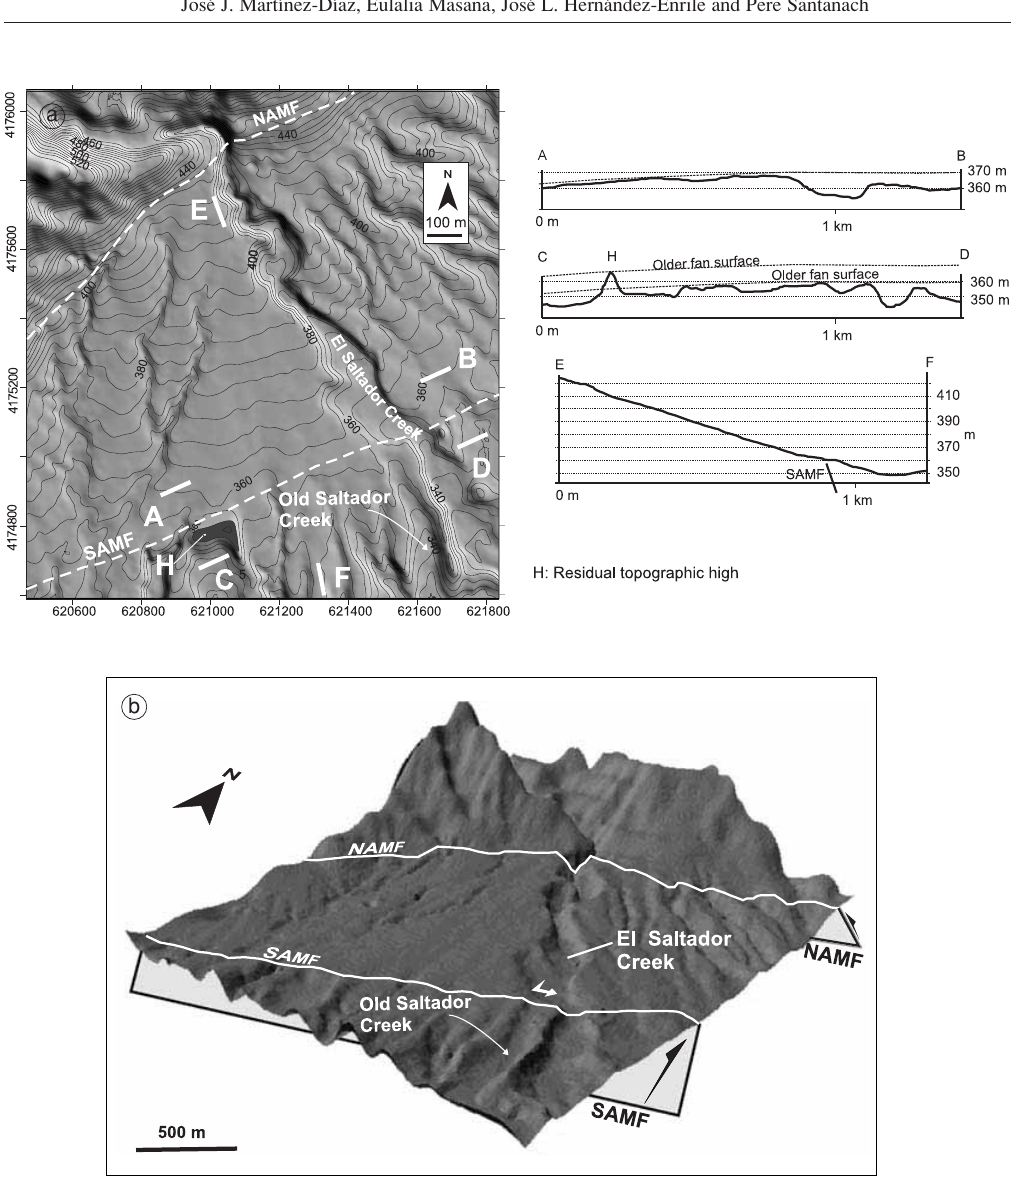
Fig. 4a,b. a) Shaded relief map processed from cartographic data at the 1:5000 scale showing the El Saltador alluvial fan together with the fault traces of the Northern and Southern Alhama de Murcia Fault (NAMF and SAMF). To the right the longitudinal (E-F) and transversal (A-B and C-D) topographic profiles of the fan show different degree of dissection of the fan surface in the foot-wall and hanging-wall of the SAMF. H represents a relict of an old fan surface uplifted in the hanging-wall of the SAMF (upper dashed line in profile C-D). b) Oblique view of the fan surface from the southeast showing the morphology of the fan surface in rela- tionship with the geometry of the two fault strands, and the capture (arrow) experienced by the El Saltador Creek in the fault zone due to headward erosion triggered in the hanging wall by the uplift.